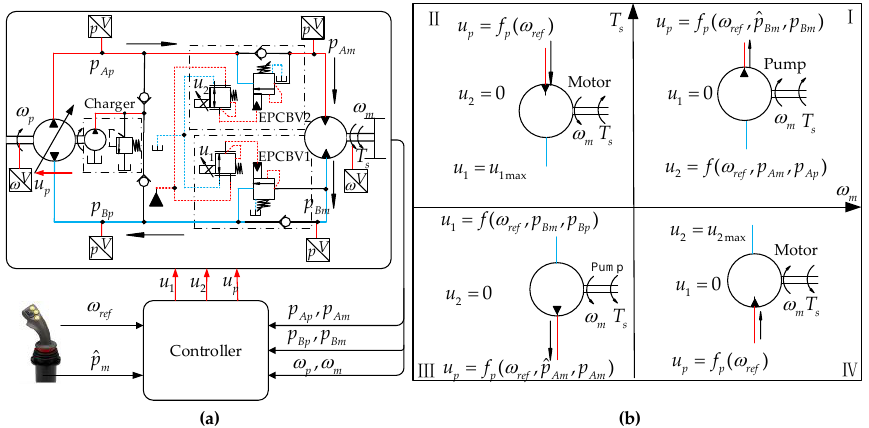
Figure 3. ( a ) Proposed configuration with EPCBV for PCMH system, ( b ) four-quadrant operation modes for the proposed scheme.